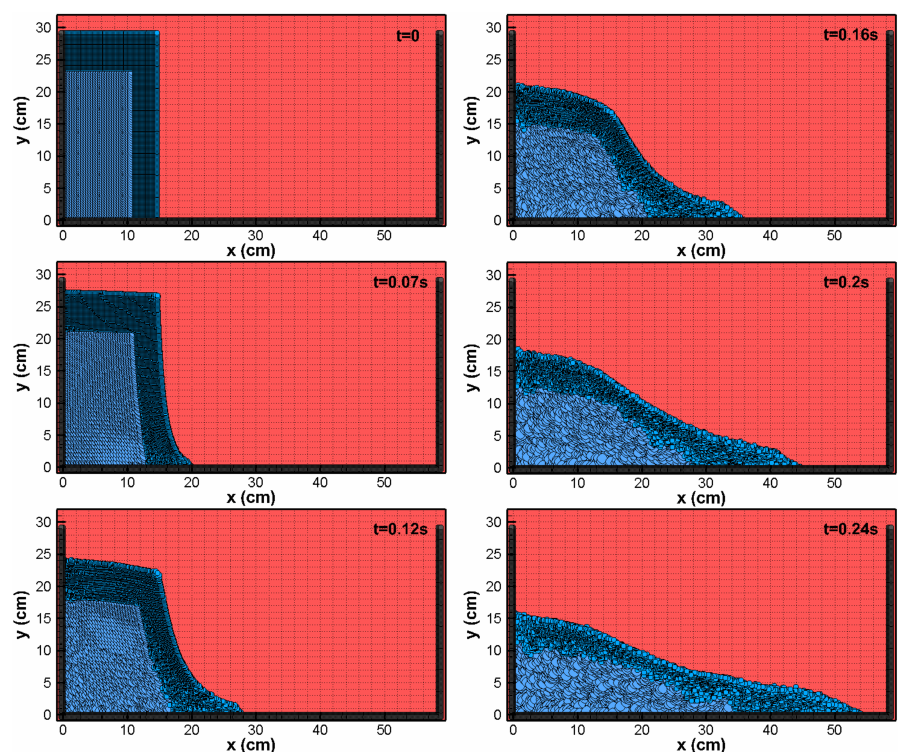
Figure 8. Particle configuration for dam-break computed by the proposed MR-WC-MPS method.